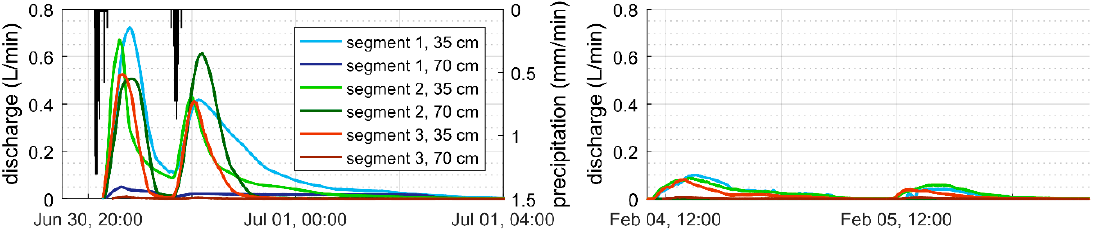
Figure 5. Characteristic subsurface flow event types. Left: rain-induced convective event (June 2016); right: thawing event (February 2017).